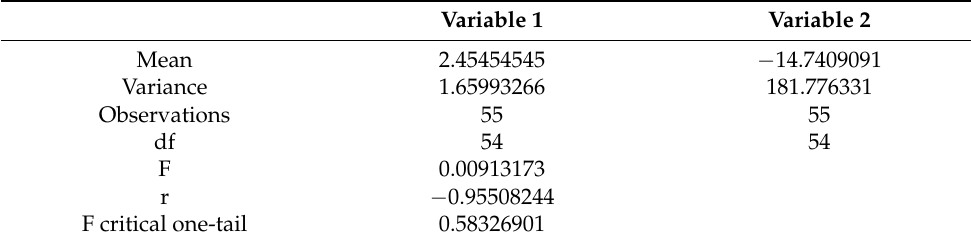
Table 2. Fisher´s two-sample F-test for variances. Table 2. Fisher ´ s two-sample F-test for